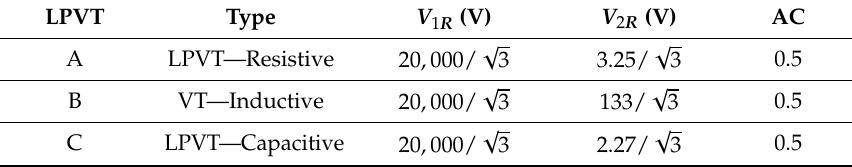
Table 1. Main characteristics of the three voltage transformers (VTs) under